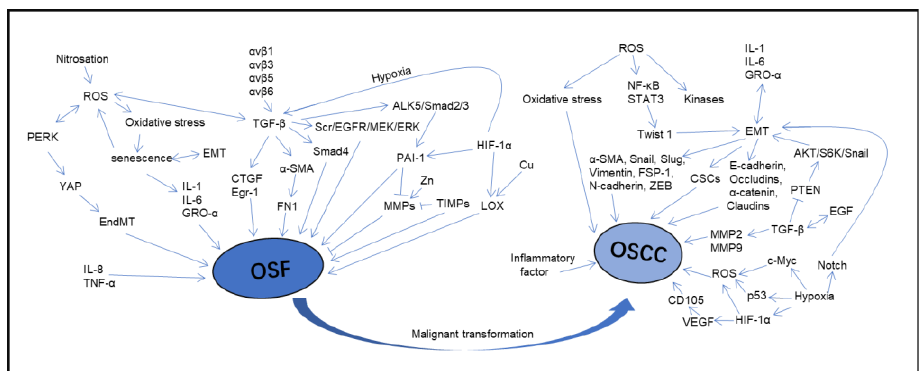
Figure 3. The important molecules and processes involved in OSF pathogenesis and malignant transformation into OSCC. Table 2. Targets and roles of miRNAs in OSF and OSCC.